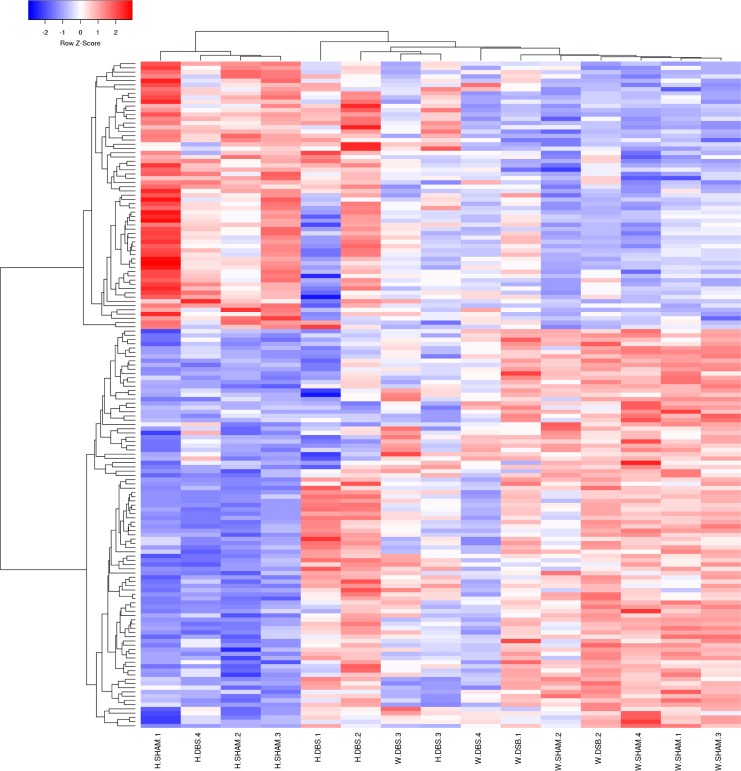
Heat map showing expression levels of protein coding genes that are significantly altered in Mecp2-heterozygous mice.RNA-Sequencing data from chronic forniceal DBS or sham treated WT and Het mice showing the level of expression of genes that are either downregulated by at least 20% (FDR < 0.05) in the Het sham mice or upregulated by at least 20% (FDR < 0.05) in the Het sham mice. Unsupervised clustering of the samples shows that 3 of the Het DBS samples cluster with the WT samples.